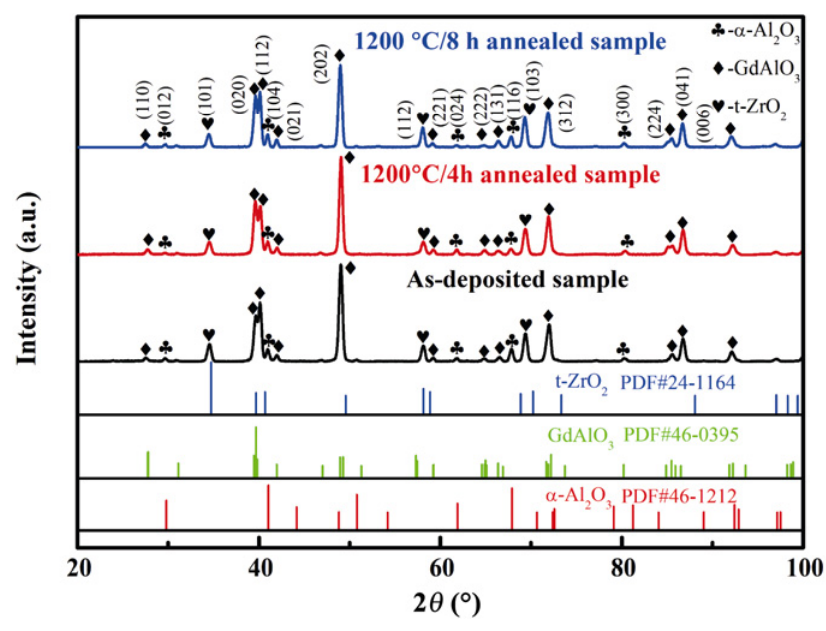
Fig. 7 XRD patterns of the as-deposited and the annealed Al 2 O 3 /GdAlO 3 /ZrO 2 eutectic samples.